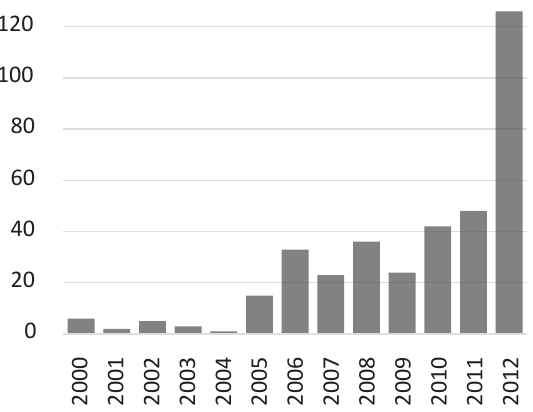
Figure 1. Frequencies of share